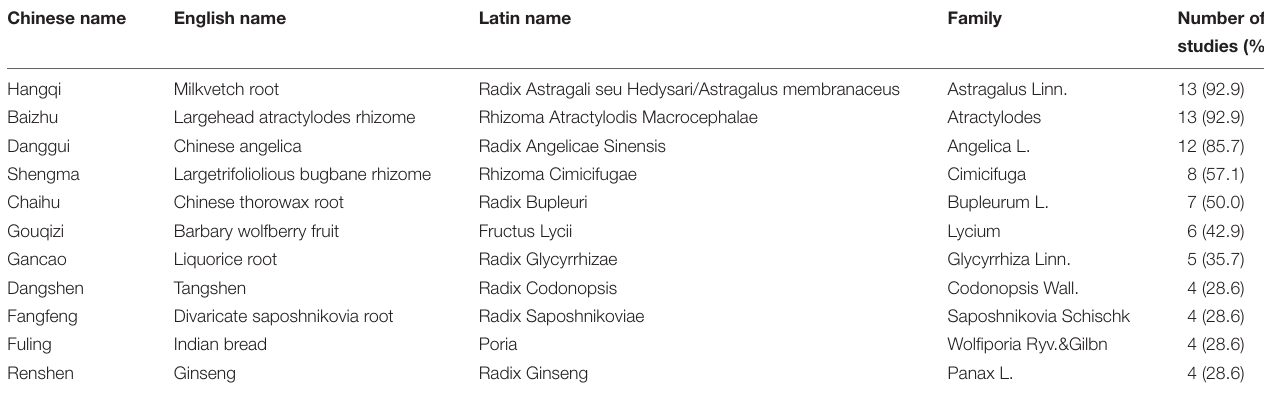
TABLE 4 | Frequently used herbs in included